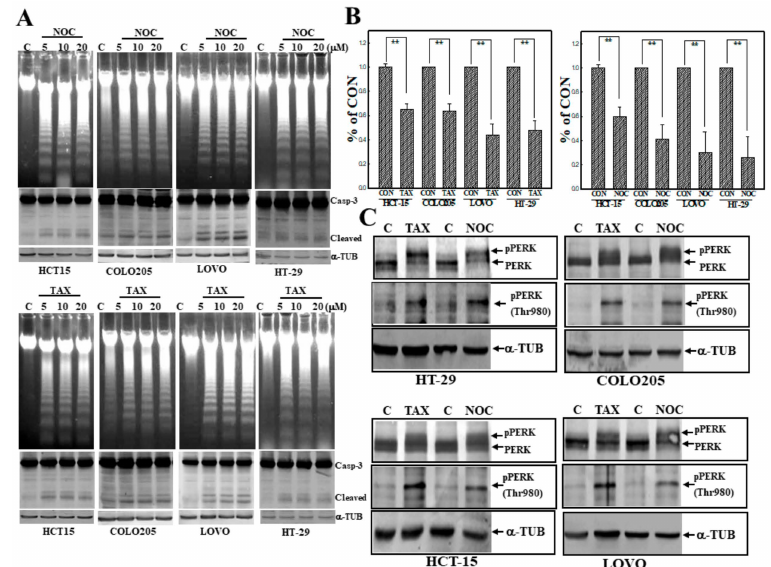
Figure 1. Taxol (TAX) and nocodazole (NOC) induced DNA ladders with increased protein kinase RNA-like endoplasmic reticular kinase (PERK) protein phosphorylation in human COLO205, HCT-15, LOVO, and HT-29 colorectal carcinoma (CRC) cells. ( A ) Increased DNA ladders by agarose electrophoresis and caspase-3 (Casp-3) protein cleavage by Western blotting in TAX- and NOC-treated CRC cells. Four CRC cells were treated with di ff erent concentrations (5, 10, and 20 µ M) of TAX or NOC for 24 h, and DNA integrity and Casp-3 protein of cells was detected by agarose electrophoresis and Western blotting, respectively. ( B ) TAX and NOC reduced the viability of CRC cells according to an MTT assay. CRC cells were treated with TAX or NOC (10 µ M) for 24 h, and the viability of CRC cells was examined by an MTT assay. Data are presented as a percentage of the control (% of CON) from three independent experiments. ( C ) TAX and NOC induced PERK protein phosphorylation at Thr980 in human CRC cells. As described in ( B ), total proteins from CRC cells under various treatments were applied for Western blotting, and levels of indicated proteins, including PERK, phosphorylated (p)PERK (Thr 980), and α -tubulin ( α -TUB), were detected using specific antibodies. Each data point was calculated from three triplicate groups, and data are displayed as the mean ± SD. ** p < 0.01 denotes a significant di ff erence between indicated